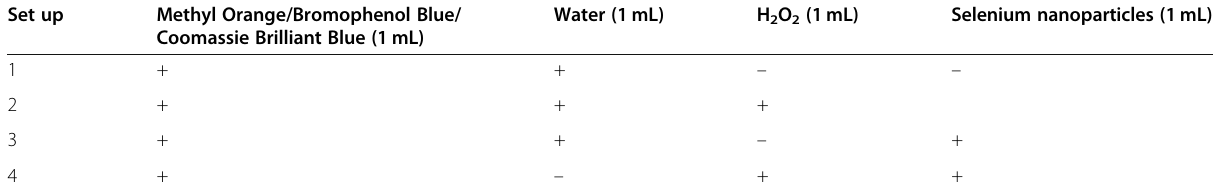
Table 2 The setups for catalytic dye degradation